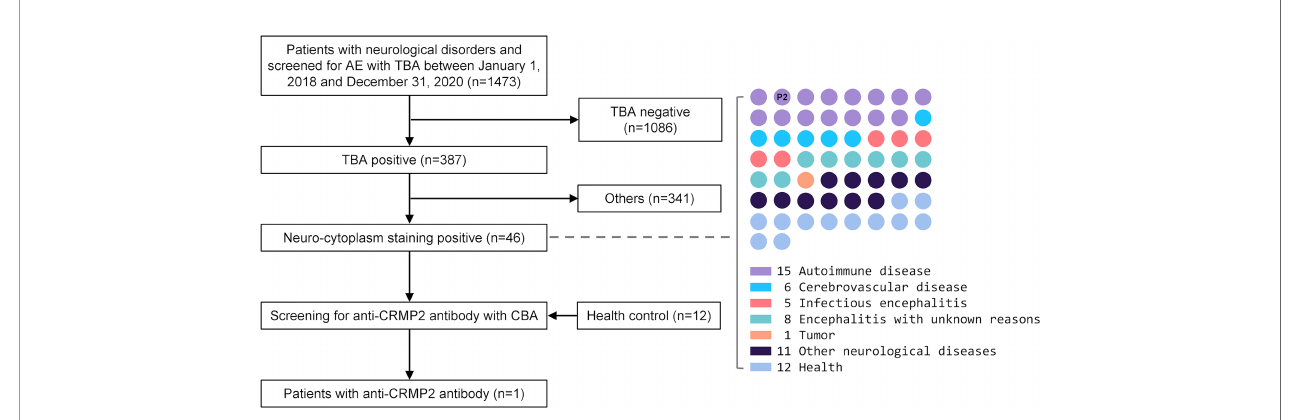
FIGURE 2 | The fl ow chart of patients selected for anti-CRMP2 antibody screening. CSFand/orserum samples from 46 patients with neurological disordersthat had positive immunostaining in the neuro-cytoplasmof rat brain sectionswere enrolled for retrospective anti-CRMP2 antibody screening. Twelve serum samples from healthy people were used as negative controls. A 42-year-old female patient with encephalomyelitis, right dot panel P2, was testedanti-CRMP2 antibody-positive inserum.AE, autoimmune encephalitis; CBA, cell-based assay;CRMP2, collapsinresponse mediator protein 2; CSF,cerebrospinal fl uid;TBA, tissue-based